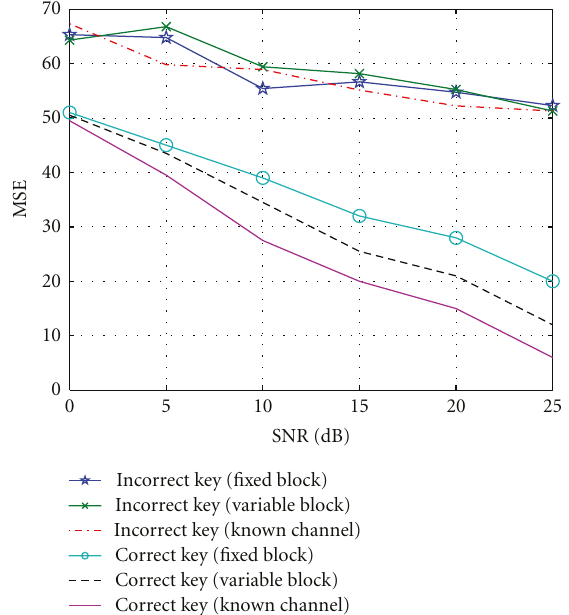
Figure 5: Data scrambling using variable block-size